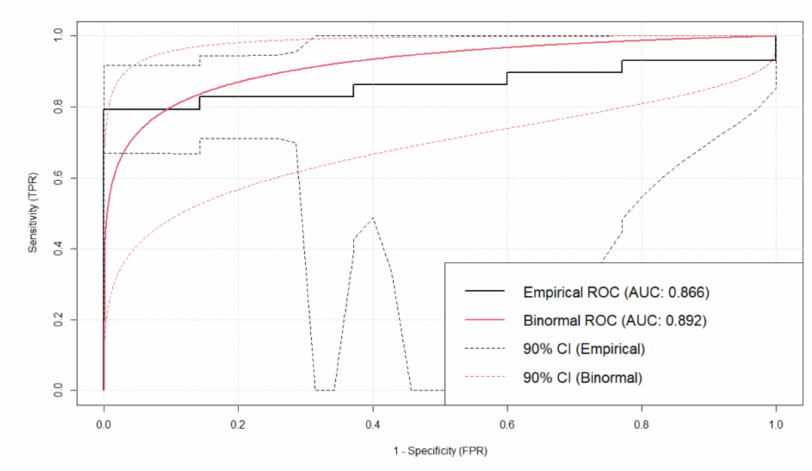
Figure 8. Validation of the LR-based novel hybrid model using empirical and binormal ROC